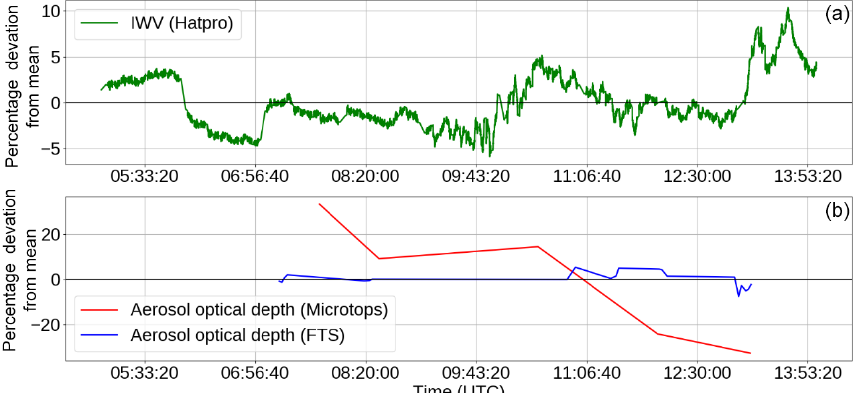
Figure 6. Percentage variation across 18 September 2008 in integrated water vapour as measured by the HATPRO microwave radiometer (a) and aerosol ( + continuum) optical depth as measured by the Microtops sunphotometer and the FTS (b) in the 1.02µm channel (9583cm − 1 in the FTS). The FTS-observed aerosol optical depth ( + water vapour continuum) is ∼ 0 . 1 in this window, while the Microtops-observed aerosol optical depth is ∼ 0 .